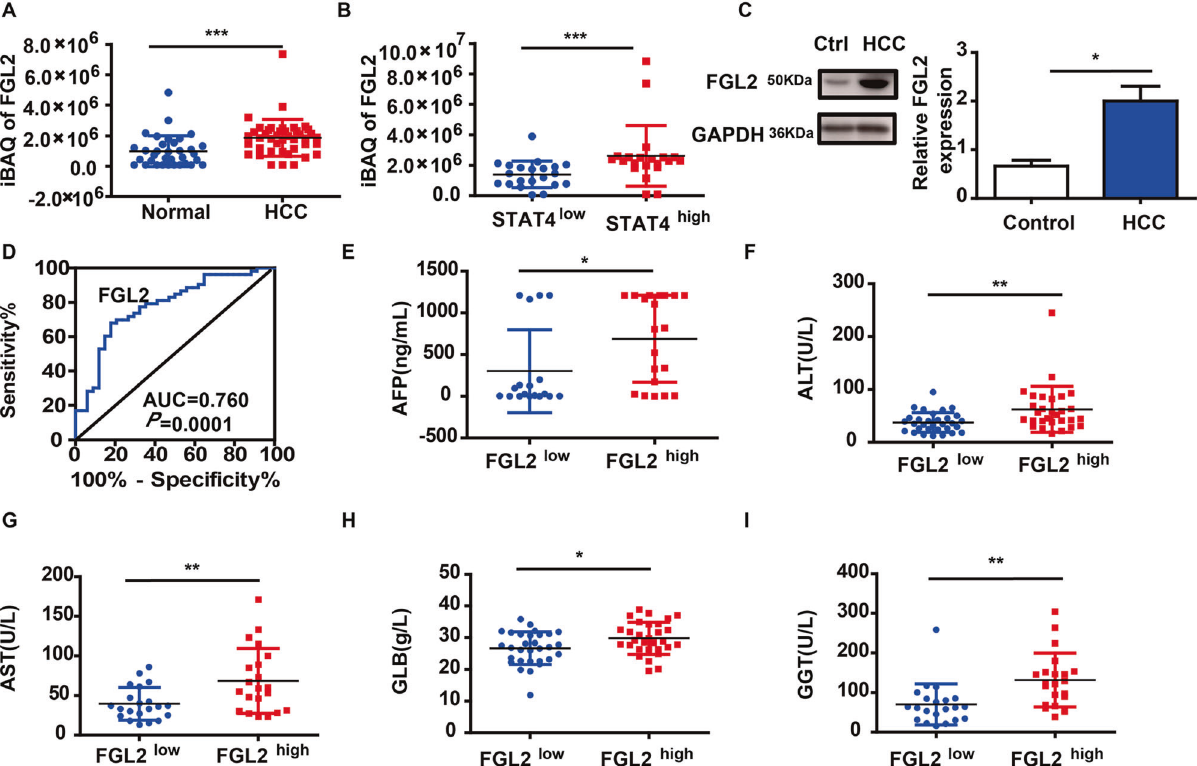
Fig. 5 The relationship between FGL2 and HCC. A Comparison of FGL2 expression levels between the normal group ( N = 34) and the HCC group ( N = 42). B Comparison of FGL2 expression levels between the low STAT4 group ( N = 21) and the high STAT4 group ( N = 21). C The expression of FGL2 in liver tissue by western blot ( N = 6), *P < 0.05, ***P < 0.001 was assessed by Student ’ s t -test. D ROC curve analysis for FGL2, AUC indicated area under ROC curve. E – I The relationship between the expression of FGL2 and clinical indicators (AFP, ALT, AST, GLB, GGT). *P < 0.05, **P < 0.01, and ***P < 0.001 was assessed by Student ’ s t